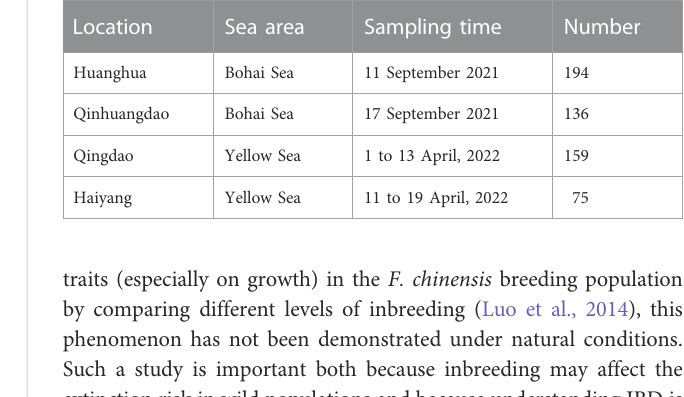
TABLE 1 Sampling locations, time, and number of the four